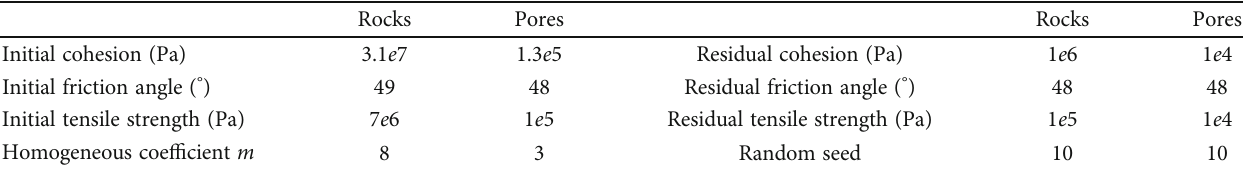
Table 2: Mechanical parameters of numerical simulation.